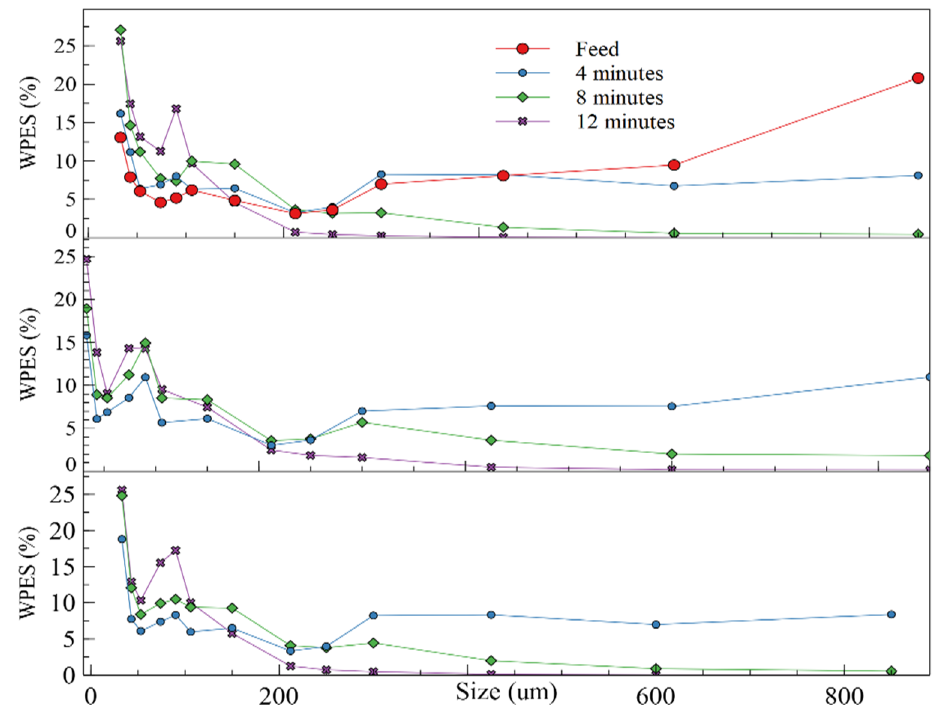
Figure A3. WPES for the same mineral: Top , with the second operating protocol (145 iron balls distributed in different sizes between 1½”, 1”, and 7/8”, with a total load of 9.341 kg; roller at 70 rpm; and 50% solid). Bottom , with the third operating protocol (238 iron balls distributed in differ- ent sizes between 1”, 7/8”, ¾”, and ½”, with a total load of 6.658 kg; roller at 70 rpm; and 67% solid).